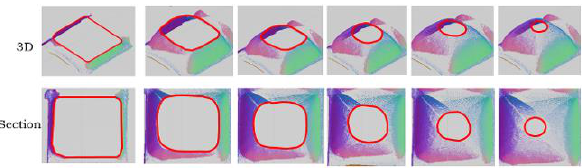
Figure 10. Sections of dome Survey 3D showing the transformations of the shape.